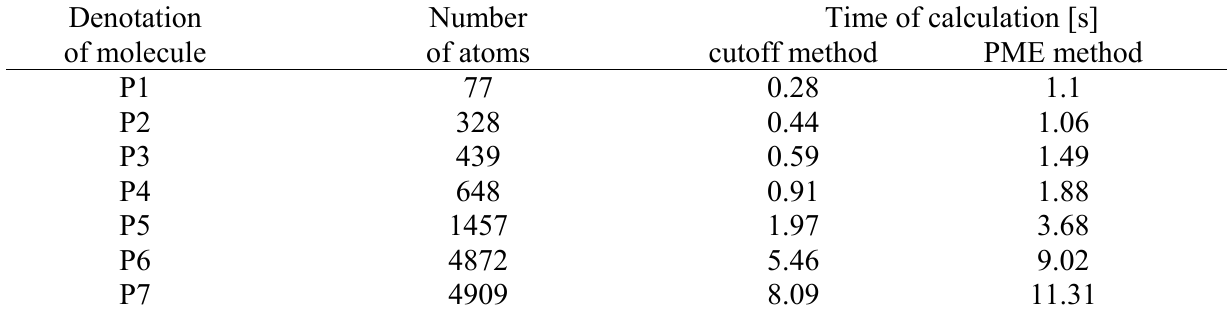
Table 3. Comparison of computational complexity of cutoff and PME method. Calculations